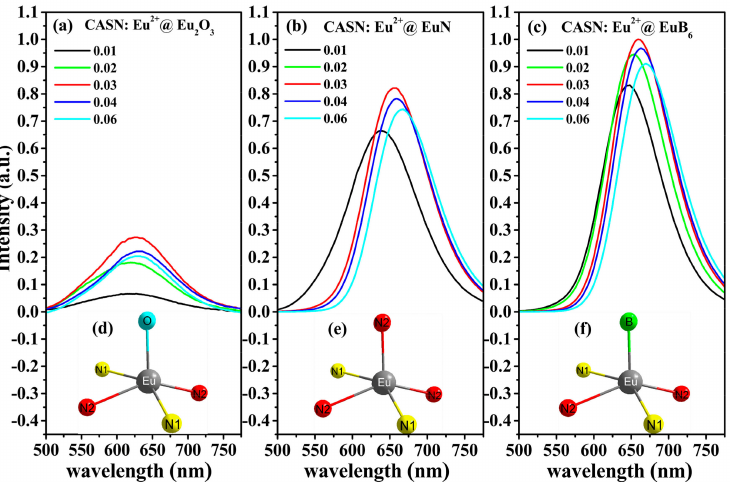
Figure 6. Photoluminescence spectra and crystallographic environments around Eu 2+ ions of three series of nitride red phosphors using different raw materials ( a ) CASN:Eu 2+ @Eu 2 O 3